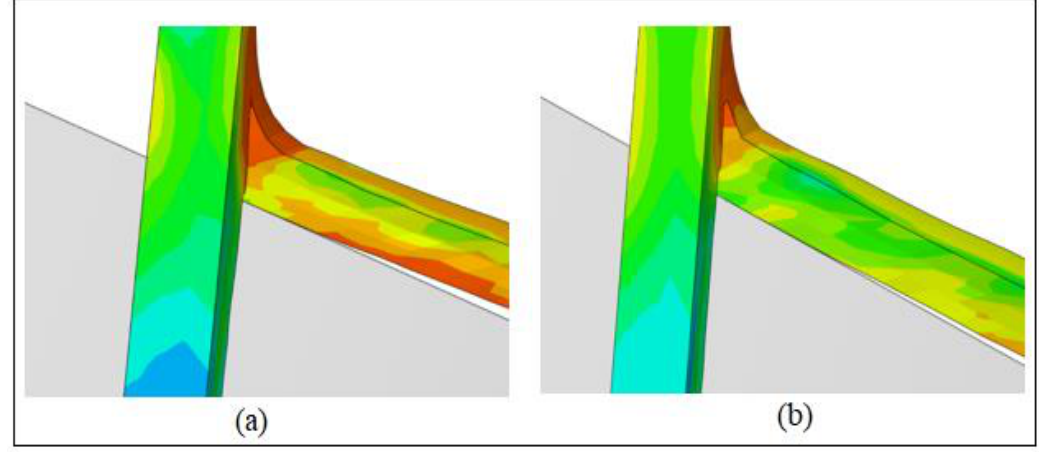
Figure 4. Tool-chip contact length at V = 100 m/min: ( a ) Rotating tool; ( b ) fixed tool.